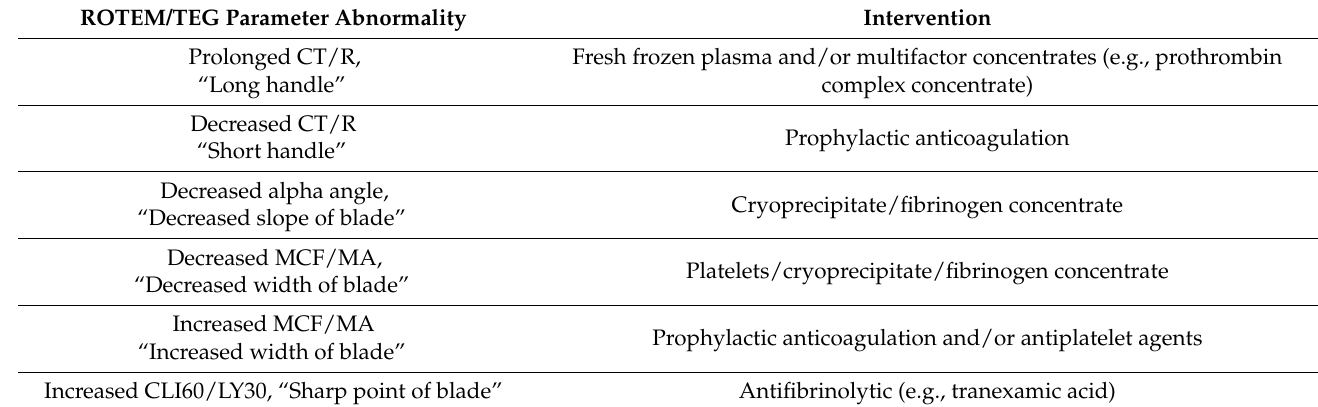
Table 1. Simplified algorithm of blood component therapy and hemostatic adjuncts based on the shovel analogy for viscoelastic hemostatic assays